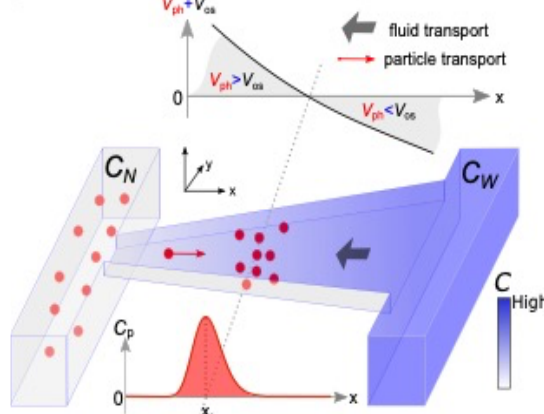
Fig. 1. Schematic of nanoparticle trapping in a funnel-shaped nanochannel by diffusioosmosis and diffusiophoresis. The salinity gradient is maintained by a continuous flow of solutions with PBS concentrations C L and C R (C L <C R ) in the